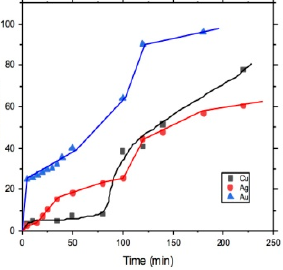
Figure 10. Maximum recoveries of Au, Cu, and Ag were obtained with the best leaching condi- tions.